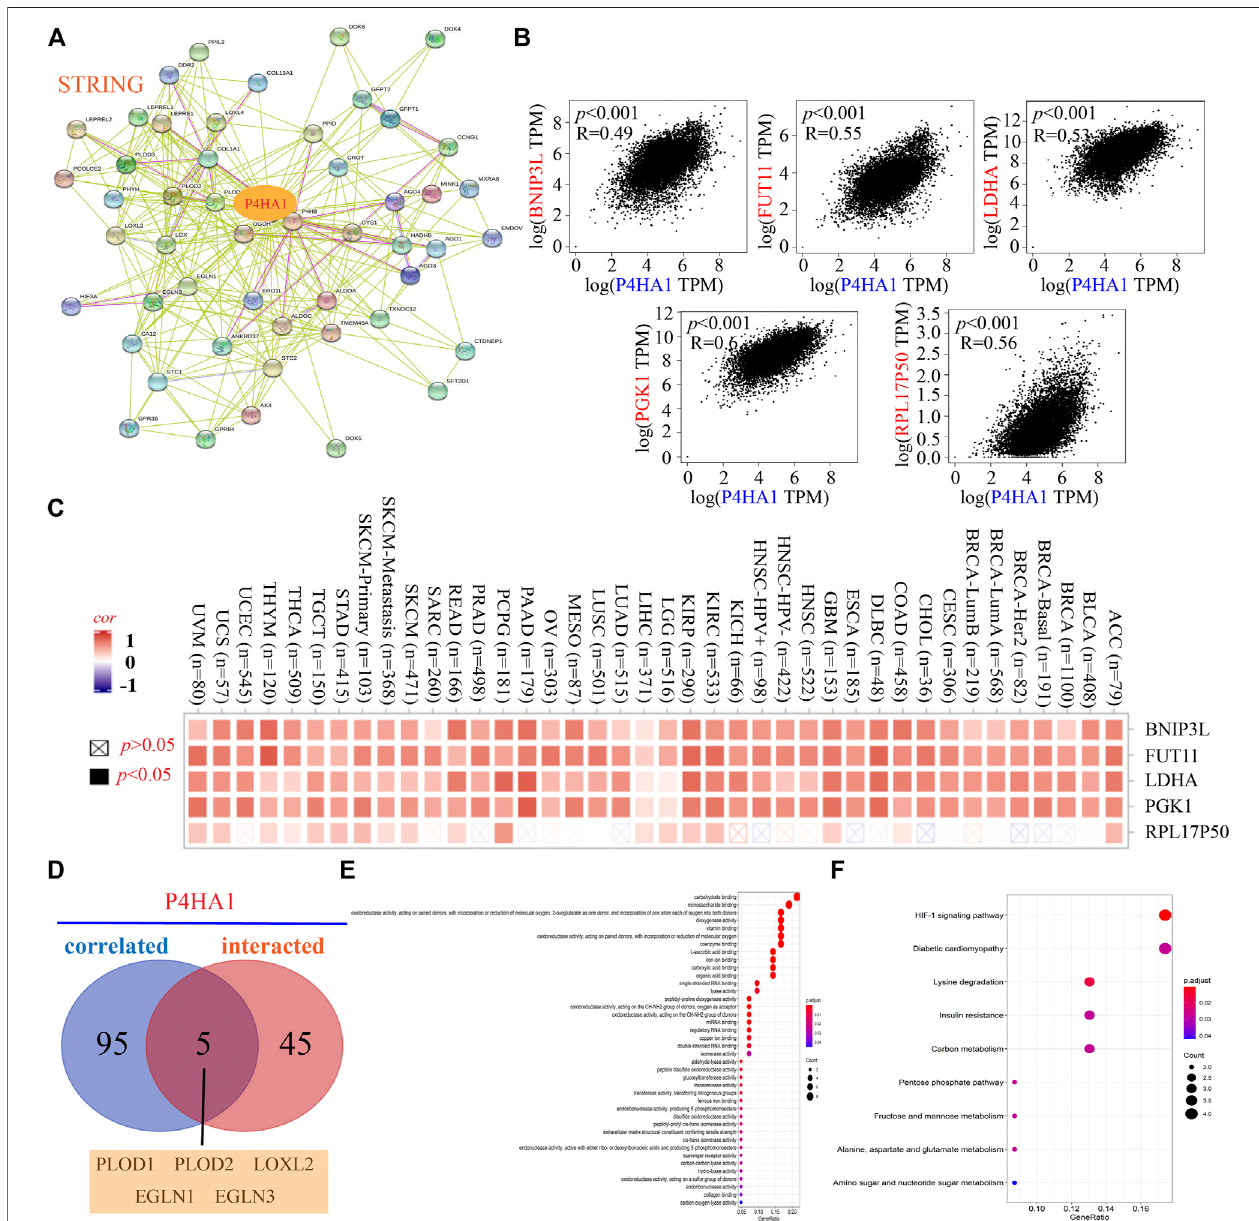
FIGURE 6 | P4HA1-related gene enrichment analysis. (A) STRING tool was applied to obtain the P4HA1-binding proteins. (B) GEPIA2 was used to obtain the top 100 P4HA1-correlated genes and analyze the expression correlation between P4HA1 and top fi ve related genes (BNIP3L, FUT11, LDHA, PGK1, and RPL17P50). (C) CorrespondingheatmapanalysisshowedthecorrelationbetweenP4HA1expressionandthe fi verelatedgenes(BNIP3L, FUT11,LDHA,PGK1,andRPL17P50)across differenttypesoftumorsinTCGA. (D) IntersectionanalysisoftheP4HA1-bindingandcorrelatedgeneswasperformed. (E) Molecularfunctiondataofthe fi vegenes (PLOD1,PLOD2, LOXL2, EGLN1,and EGLN3)in GOanalysis weredisplayed. (F) Five genes(PLOD1,PLOD2, LOXL2, EGLN1, and EGLN3) in KEGGpathway analysis were showed.